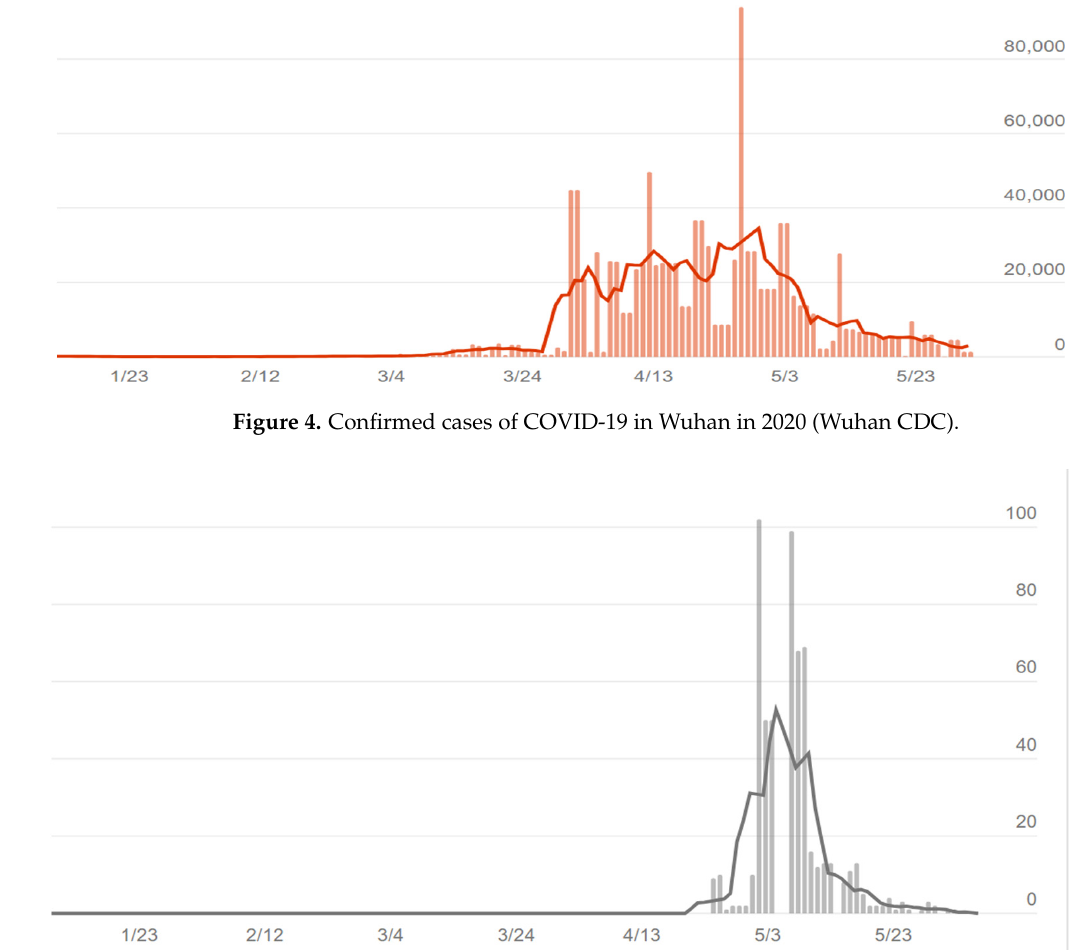
Figure 5. Number of deaths caused by COVID-19 in Wuhan in 2020 (Wuhan CDC).